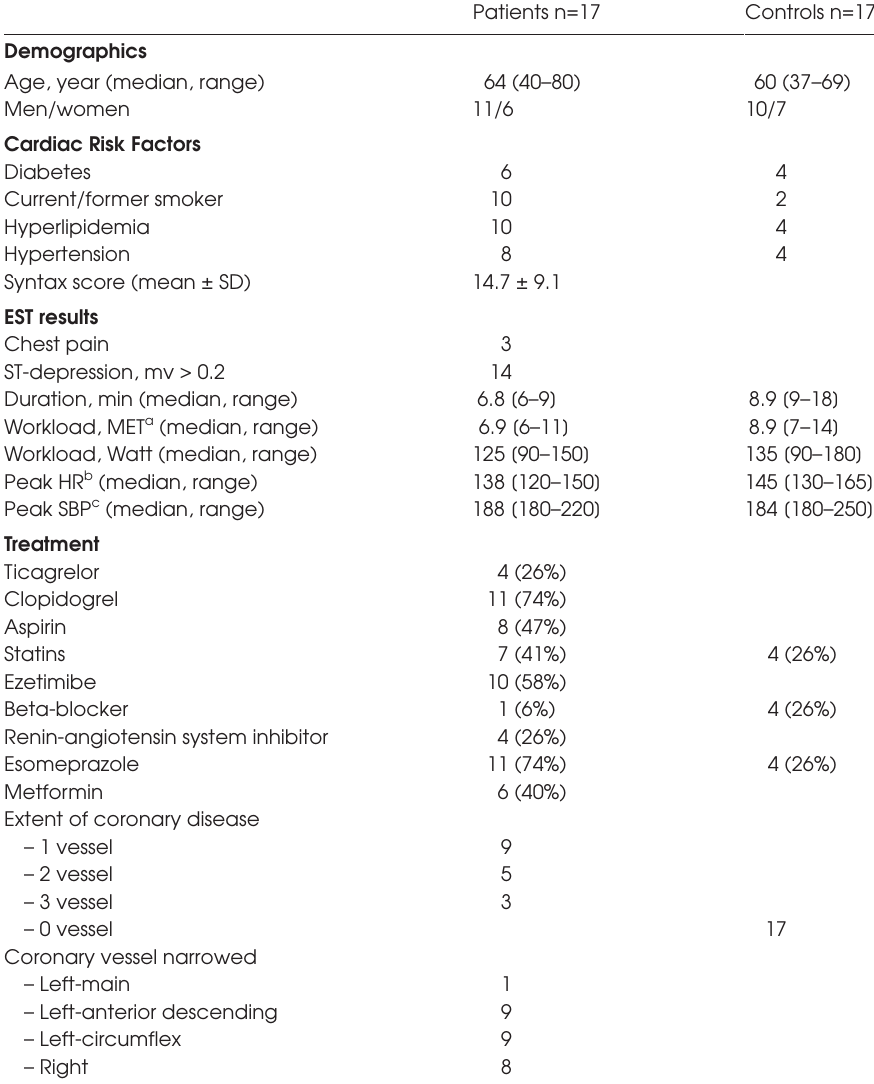
Table 1. Characteristics of patients and